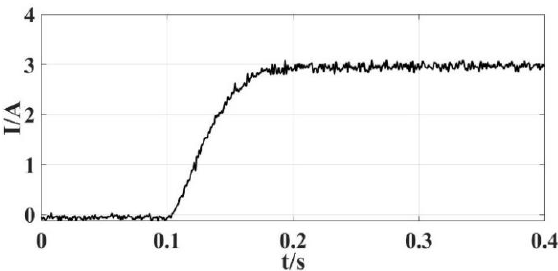
Figure 19. Current rise curve of half-bridge SPA.